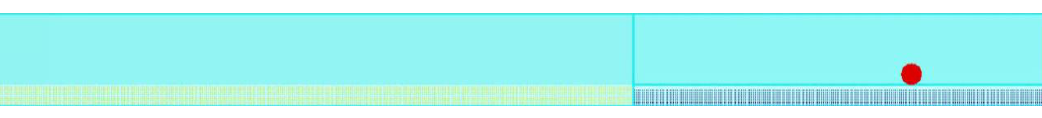
Figure 4. Compute domain mesh grid.